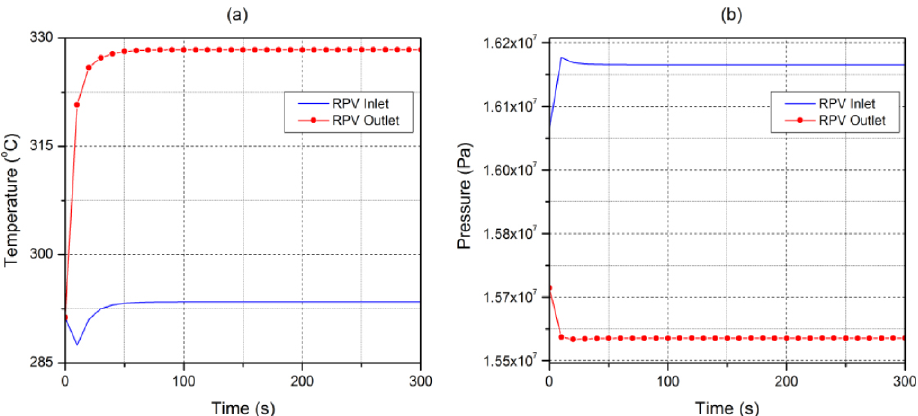
Fig. 2. Time evolution of coolant temperature (a) and pressure (b) at inlet and outlet of the RPV.